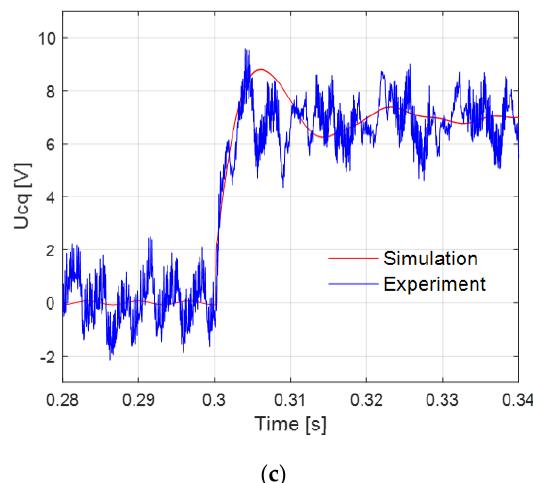
Figure 26. Step response of capacitor voltage u cq : ( a ) set 1: r c = 2.5 Ω, K vp = 0.2, f z = 700 Hz; ( b ) set 2: r c = 2.5 Ω, K vp = 0.15, f z = 400 Hz; ( c ) set 3: r c = 2.5 Ω, K vp = 0.1, f z = 200 Hz .